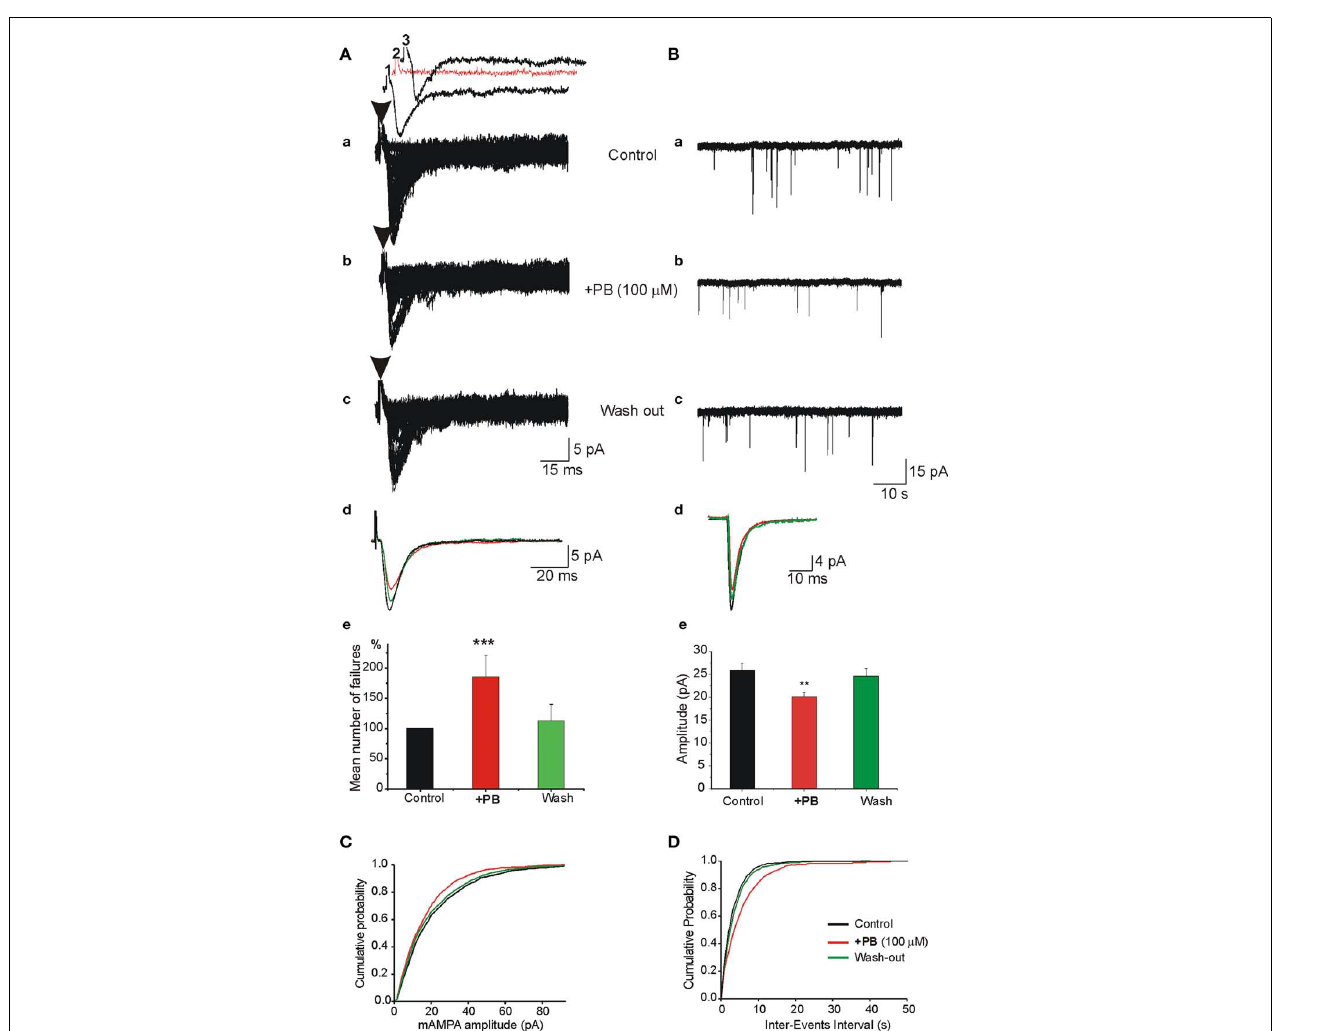
amplitude of miniature AMPA receptor mediated EPSCs (mEPSCs). APV (40 μ M) and bicuculline (10 μ M) were applied throughout the recordings as well asTTX (1 μ M) to generate mEPSCs. (Ba–c) Single traces to illustrate the actions of PB on AMPA receptor mediated mEPSCs. Note that PB (middle trace) reduced the amplitude of the minis. (Bd) Superimposed averaged traces of single mEPSCs to illustrate the effects of PB [from (Ba–c) ]. Note the reduction of the mEPSCs amplitude (red trace). (Be) Quantification of the effects of PB. Note that PB reduced significantly (by 28.9%; from 25.9 ± 1.4 to 20.1 ± 0.9pA, p < 0.01, n = 5 cells from different slices) the averaged amplitude of mEPSCs. PB also reduced the frequency of mini EPSCs (see text). (C) Cumulative probability distributions of mEPSCs amplitude in the presence of PB (red curve) demonstrate a leftward shift as compared with control and wash out. (D) Cumulative probability distribution of mEPSCs inter-event intervals in the presence of PB demonstrates a rightward shift as compared with control and wash